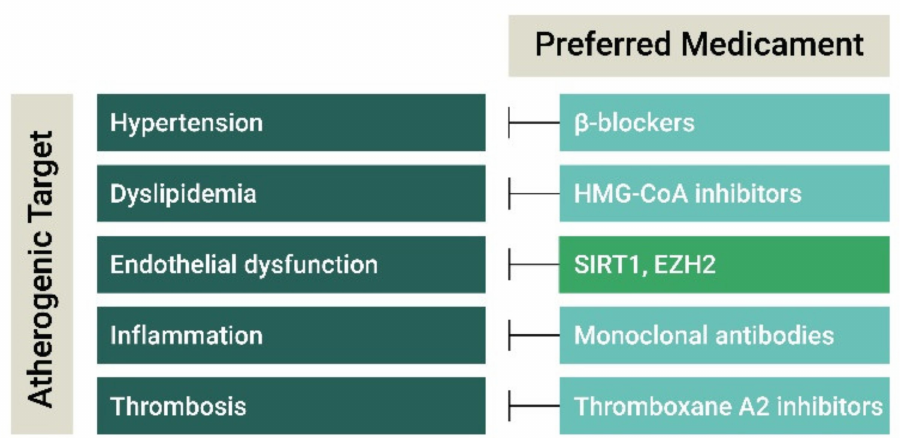
Figure 2. Current and future anti-atherogenic therapies. Established atherogenic risk factors and processes are depicted in green bars and the current available and experimental therapies to counteract these atherogenic processes are depicted in the neighbouring bars. Current anti-atherogenic therapies successfully preclude hypertension, dyslipidaemia, inflammation, and thrombosis, however, endothelial dysfunction is not specifically targeted therapeutically. In this review we explain that the therapeutic targeting of the epigenetic enzymes EZH2 and SIRT1 mitigates endothelial cell activation and dysfunction and may block